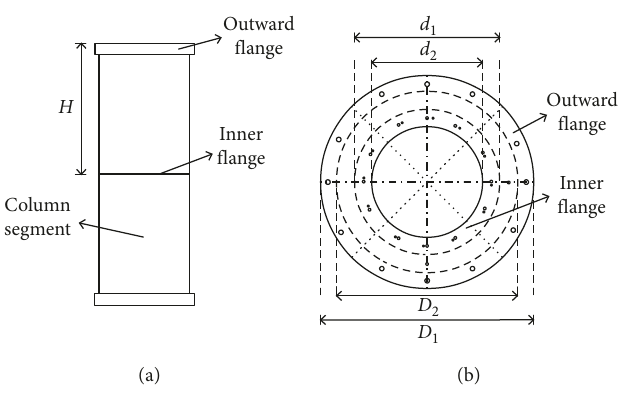
Figure 2: The diagram of dimensioning.